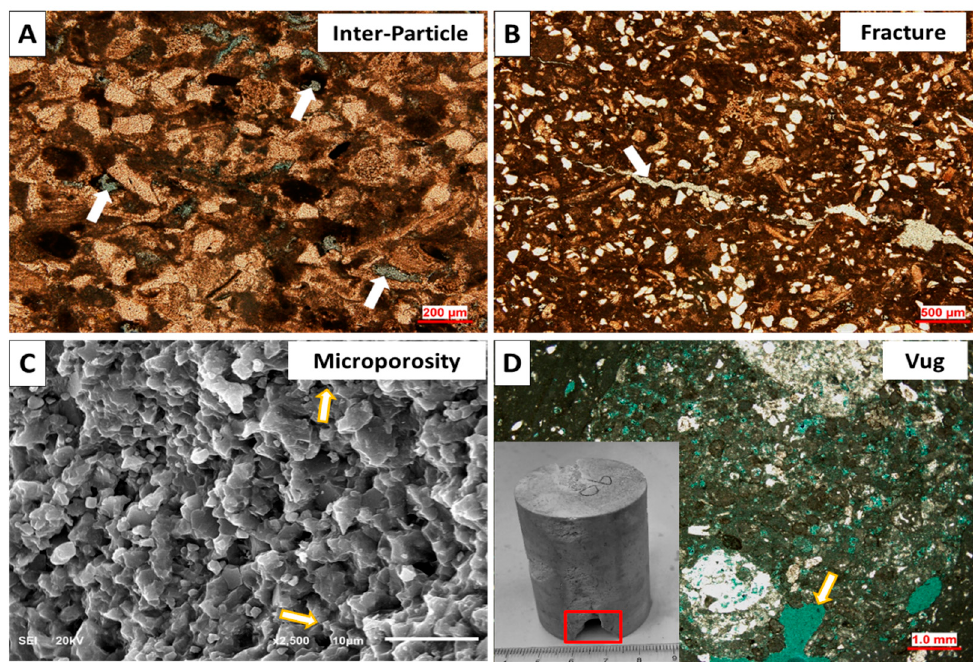
Figure 5. Pore types of the Hanifa Formation: ( A ) Inter-particle pores. ( B ) Fracture pores. ( C ) Microporosity. ( D ) Vugs on plug (red rectangle) and thin-section (arrow).